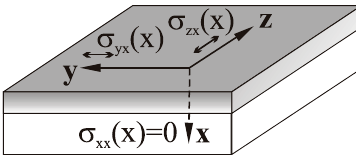
Figure 1. Stress directions in a planar waveguide.